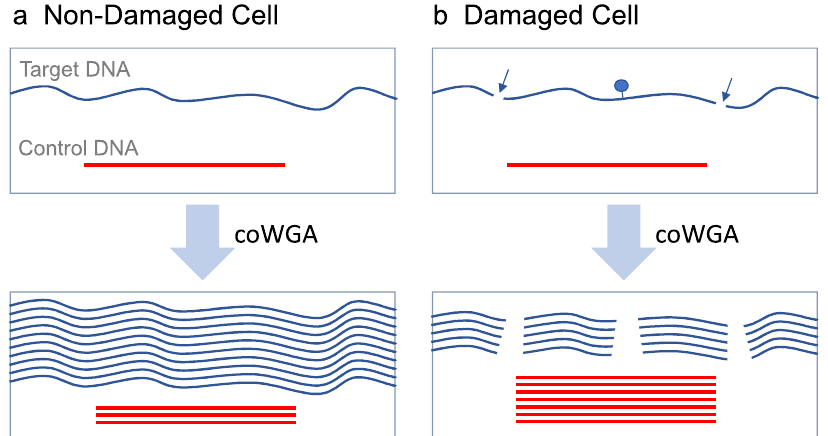
Figure 1. Competitive whole genome amplification (coWGA) of Control-DNA (red line) and single cell DNA (blue line). ( a ) In non-damaged cells, the double-stranded DNA is mostly intact and does contain very few blocking sites. Here, cellular DNA is longer than Control-DNA. In this case, the amplification of the large, unbroken double-stranded DNA out-competes the amplification of the Control-DNA. ( b ) In damaged cells, genomic DNA may have multiple breaks (arrows) and sites blocking Phi29 polymerase (blue dot). As a result, the amplification rate is reduced and the large sized Control-DNA outcompetes the amplification of the low quality cellular DNA. A high amount of Control-DNA indicates a low quality of cellular target DNA and vice